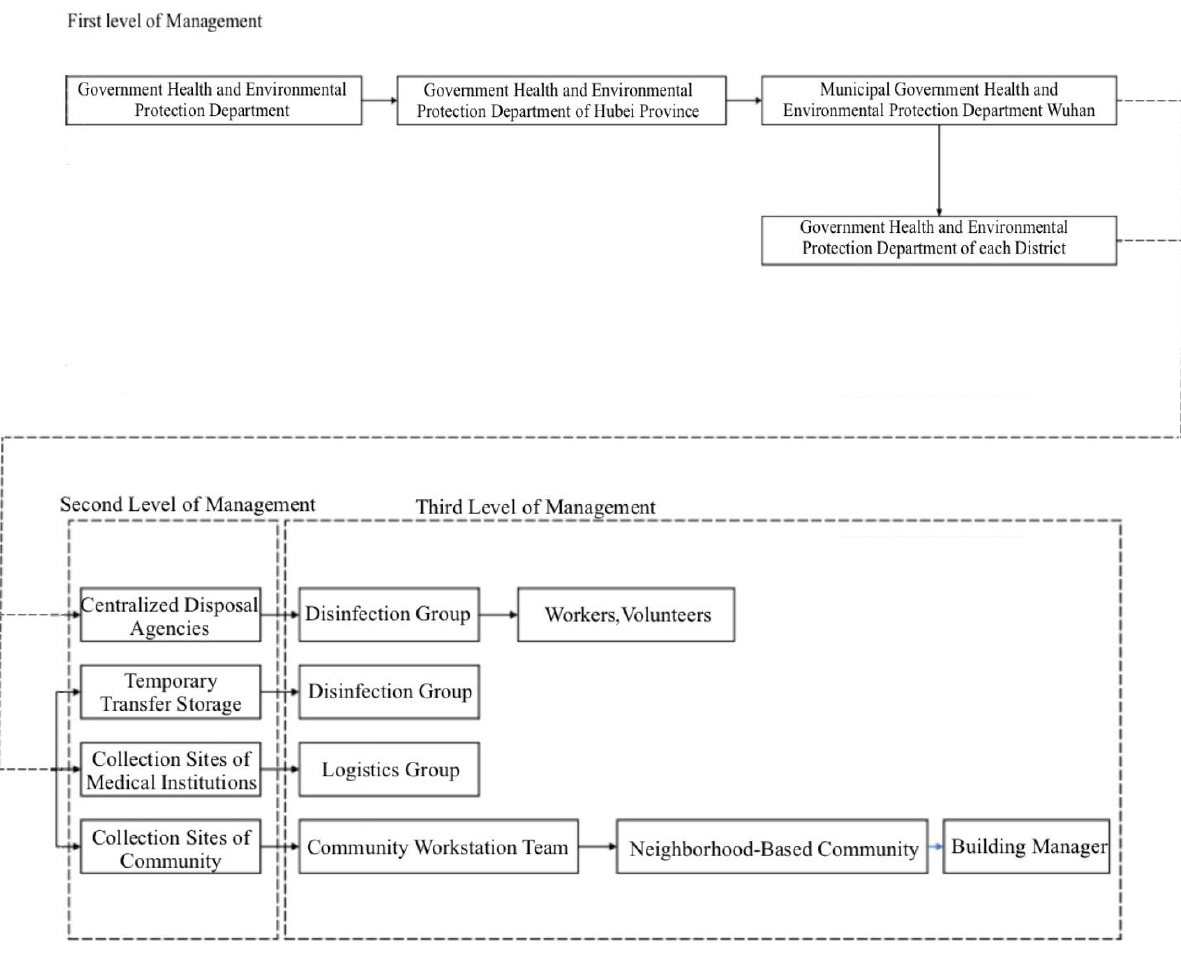
Figure 6. Medical waste hierarchy management system.